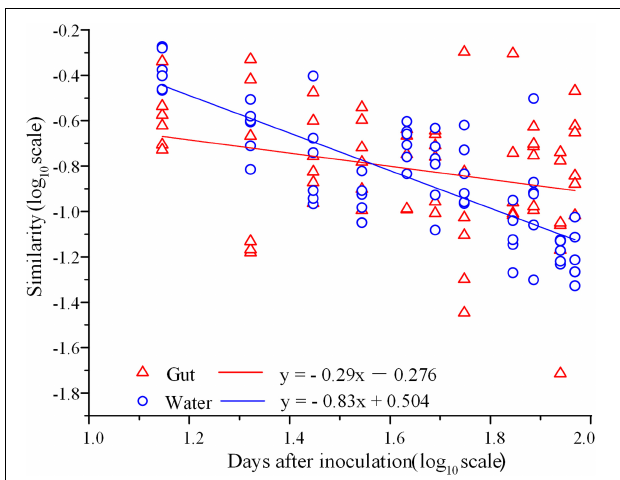
FIGURE 2 | Time-decay relationship for shrimp gut microbiota and bacterioplankton communities. The x -axis is log in days postlarval shrimp inoculation, and y -axis is log (similarity) calculated using the Bray-Curtis distance ( R = 0.407, p =